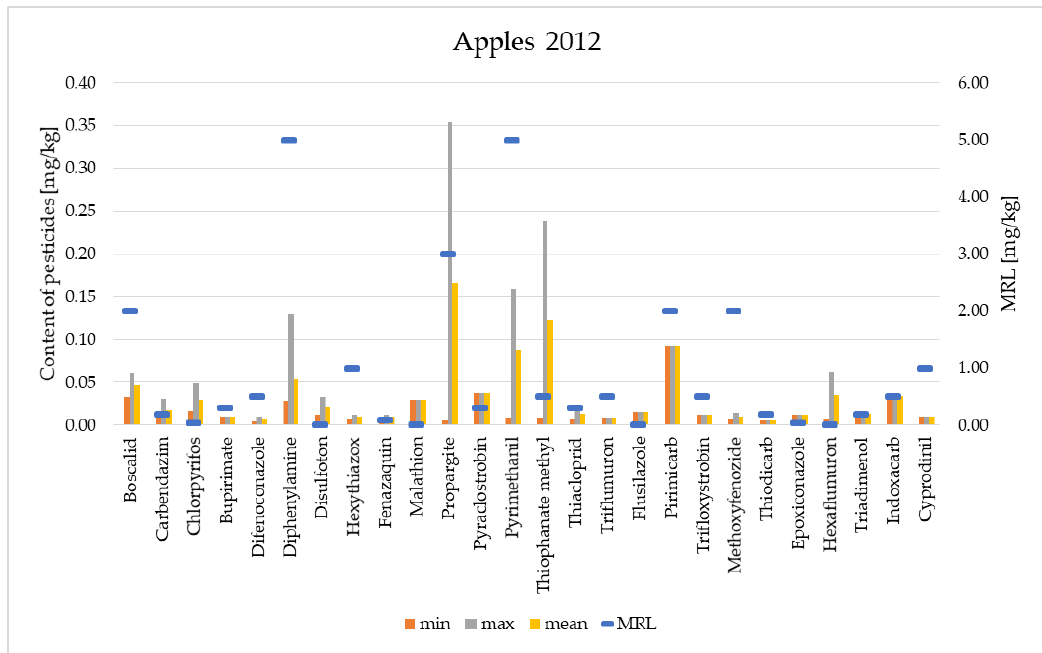
Figure 1. Content of pesticides in samples of whole apples from the harvest of 2012.